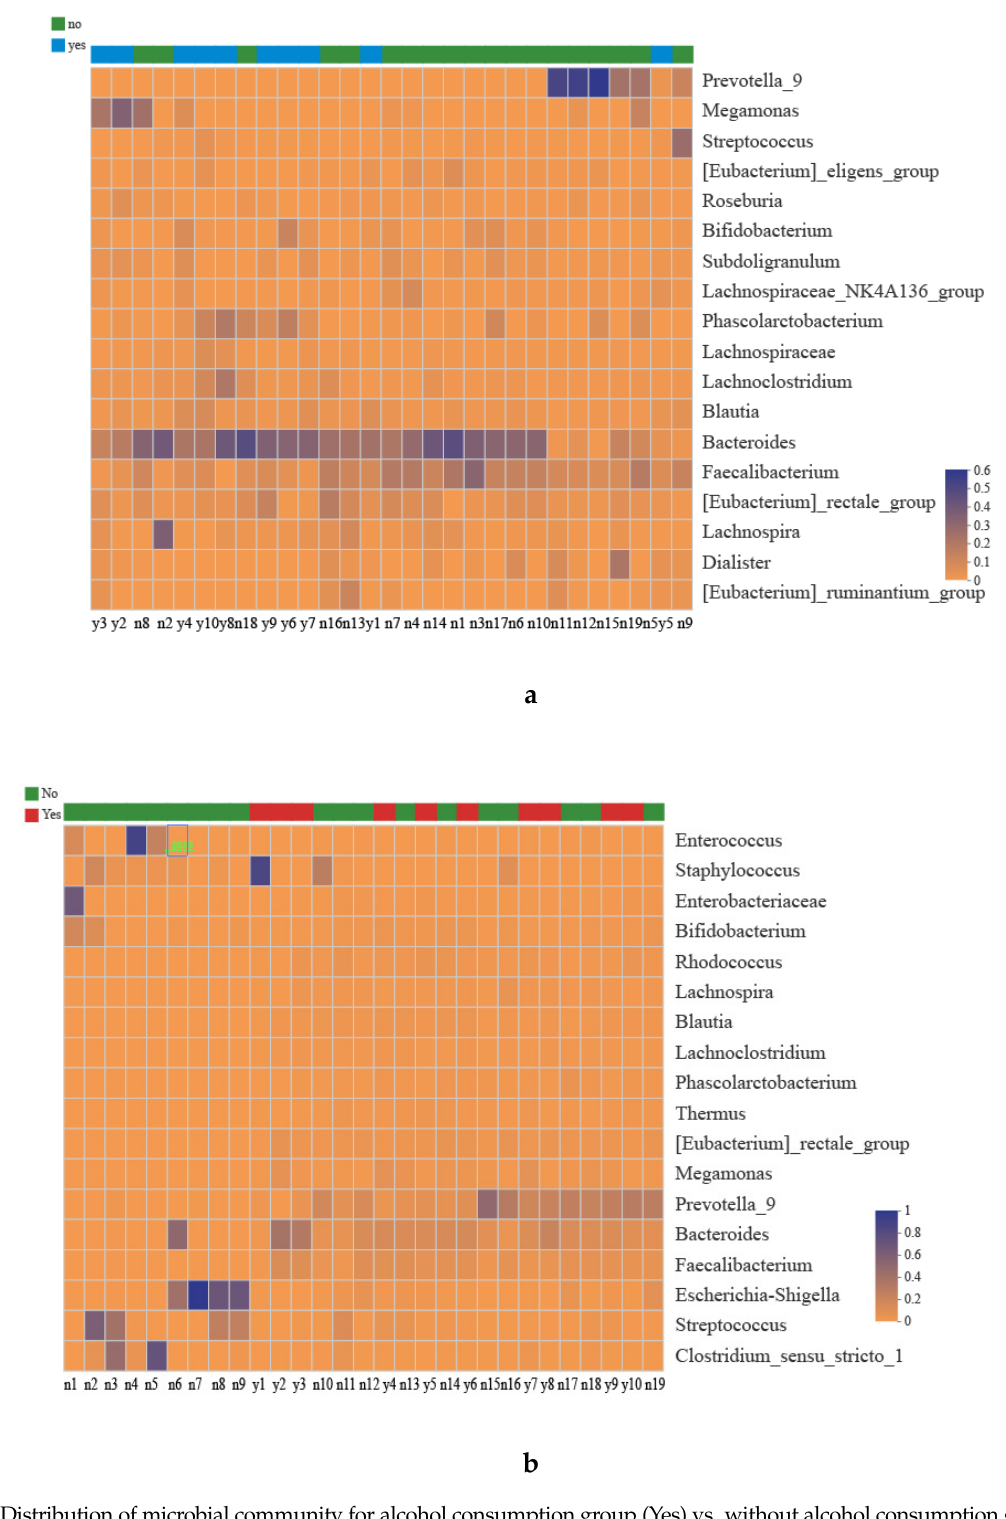
Figure 1. Distribution of microbial community for alcohol consumption group (Yes) vs. without alcohol consumption group (No) at genus level were visualized by community heatmap ( ≥ 1% relative abundance). The abundance of different samples reflects through color changes: ( a ) indicates maternal gut microbiota composition; ( b ) indicates newborns’ gut microbiota composition.